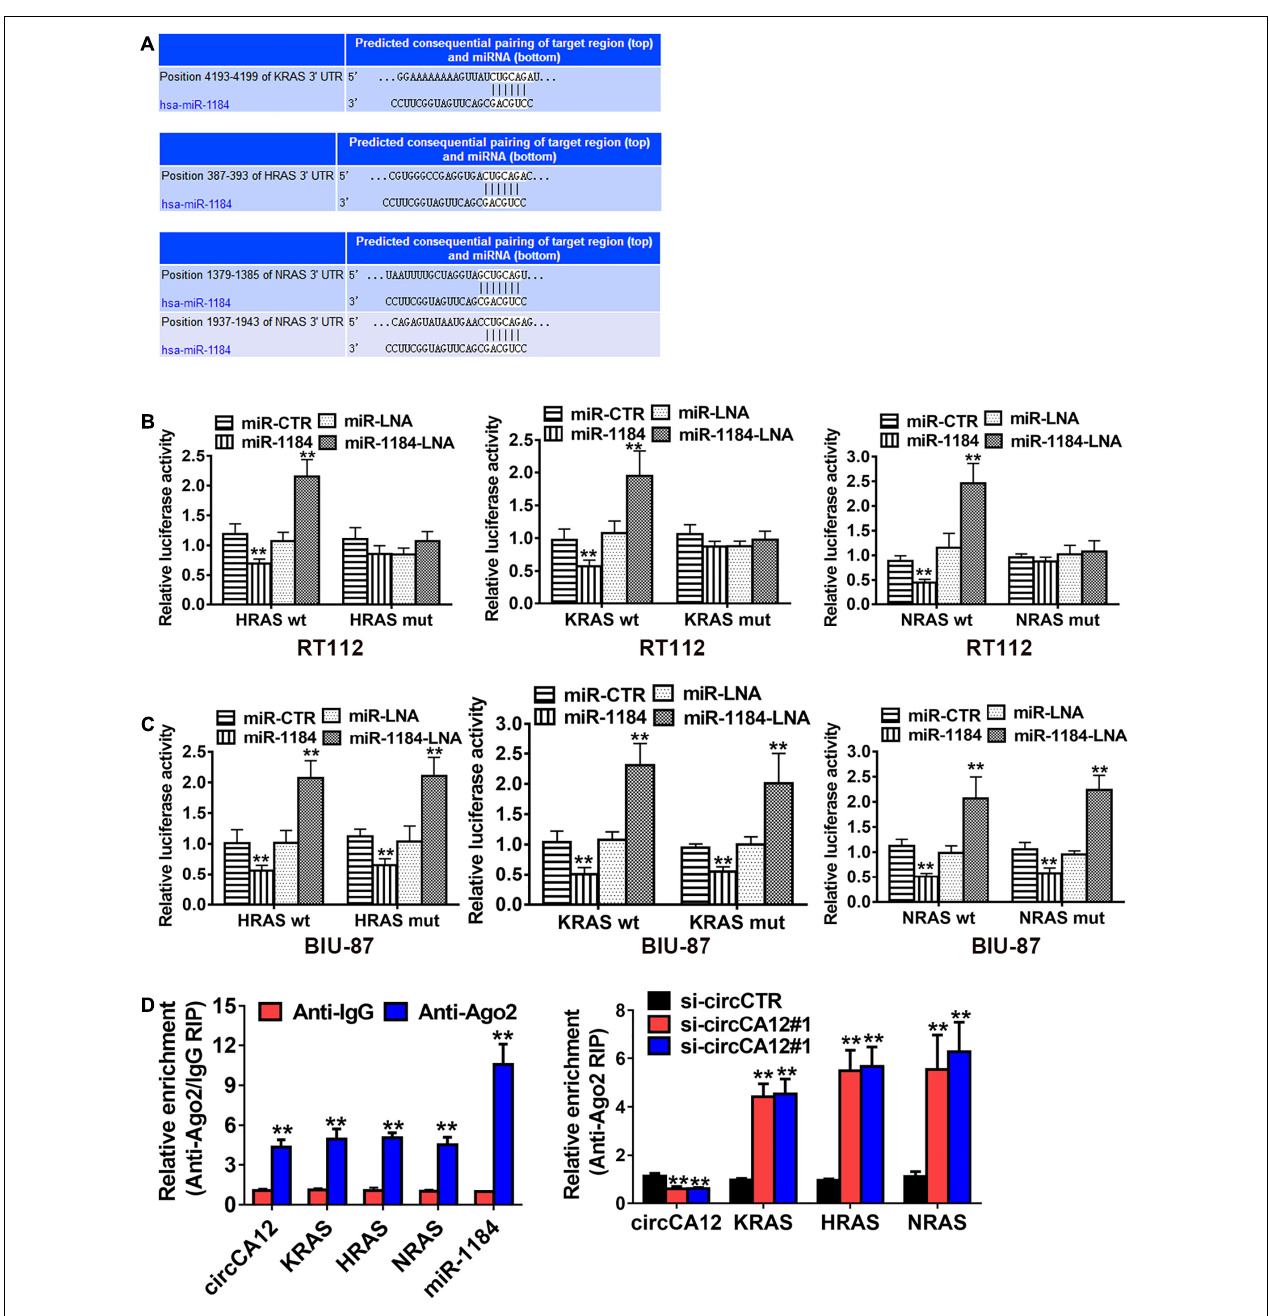
FIGURE 5 | CircCA12 enhances bladder cancer development through the circCA12/mir-1184/RAS family pathway. (A) Docking sites of miR-1184 in the 3 (cid:48) -UTR of KRA/HRA/NRAS predicted by TargetScan web resource (http://www.targetscan.org). (B,C) Luciferase enzyme reporter analysis. We transfected miR-1184 mimics, locked nucleic acid (LNA), as well as control groups into circCA12 wild type or mutant luciferase reporter in RT-112 and BIU-87 cells. The predicted miR-1184 binding sites of 3 (cid:48) -UTR of HRAS/KRAS/NRAS were mutated. (D) RIP assay. CircCA12, miRNA-1184, and KRAS/HRAS/NRAS were abundant in the Ago2 complex in contrast with the lgG group, and enrichment of KRAS/HRAS/NRAS was elevated after silencing circCA12. CircCA12, miRNA-1184, and KRAS/HRAS/NRAS expression were measured by RT-qPCR analysis. ** P <